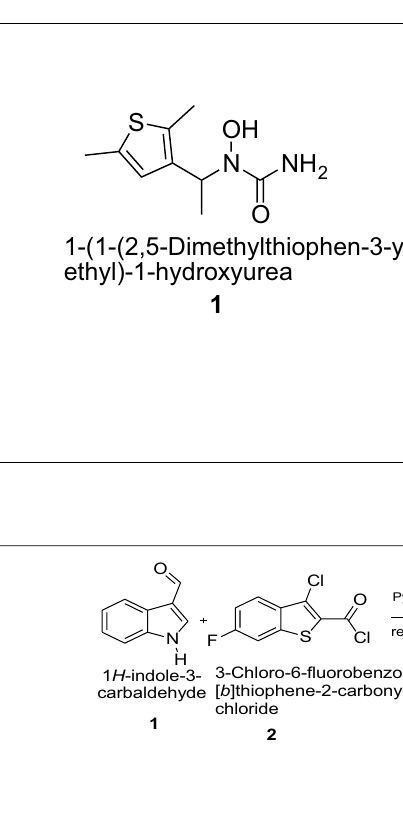
Griseofulvin for antifungal drug =